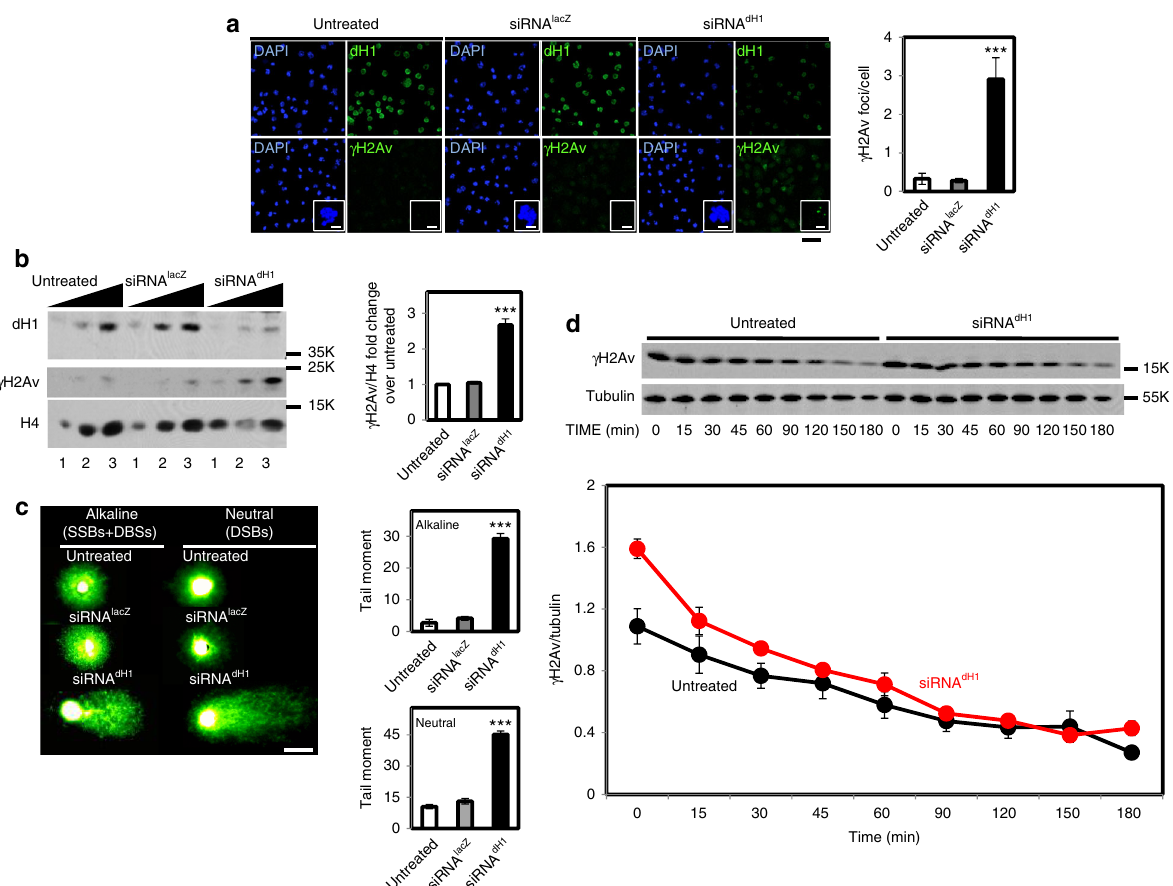
Fig. 1 dH1 depletion induces DNA damage. a Immunostaining of dH1-depleted (siRNA dH1 ) and control undepleted cells (siRNA lacZ and untreated) with α dH1 and αγ H2Av antibodies (both in green ). DNA was stained with DAPI ( blue ). Insets show enlarged images of representative individual cells. Scale bars are 20 μ m and 2 μ m in the Insets . On the right , the number of γ H2Av foci per cell is presented ( n > 100 for each condition). Error bars are s.e.m. The p -value of siRNA dH1 respect to siRNA lacZ is indicated (*** p < 0.005; two-tailed Student ’ s t -test). b WB analyses with α dH1, αγ H2Av and α H4 of increasing amounts of extracts (lanes 1 – 3) prepared from siRNA dH1 , siRNA lacZ and untreated cells. The positions corresponding to molecular weight markers are indicated. On the right , quantitative analysis of the results ( N = 3). Error bars are s.e.m. The p -value of siRNA dH1 respect to siRNA lacZ is indicated (*** < 0.005; two-tailed Student ’ s t -test). c Alkaline and neutral single-cell electrophoresis analyses of siRNA dH1 , siRNA lacZ and untreated cells. Scale bar corresponds to 20 μ m. On the right , relative comet-tail moments are presented ( n > 100 for each condition). Error bars are s.e.m. The p -values of siRNA dH1 respect to siRNA lacZ are indicated (*** < 0.005; two-tailed Student ’ s t -test). d On the top , WB analysis with αγ H2Av and α tubulin at different time points after X-ray irradiation (10 Gy) of siRNA dH1 and untreated cells. The positions corresponding to molecular weight markers are indicated. On the bottom , quantitative analysis of the results ( N =